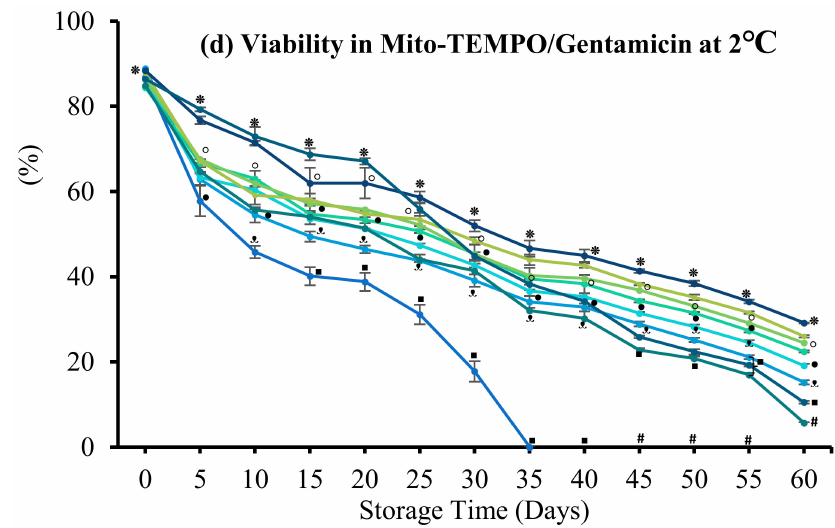
Figure 6. Effect of Mito-TEMPO on spotted halibut ( Verasper variegatus ) sperm stored in Stein’s solution (1:4) + neomycin (N) or gentamicin (G) at 2 ◦ C for 60 days. ( a ) Motility in neomycin (%), ( b ) Figure 4. Effect of gentamicin (G) on the sperm of spotted halibut ( Verasper variegatus ) stored in Stein’s solution for 60 days at 2 °C. ( a ) Motility (%), ( b ) viability Figure 4. Effect of gentamicin (G) on the sperm of spotted halibut ( Verasper variegatus ) stored in Stein’s solution for 60 days at 2 °C. ( a ) Motility (%), ( b ) viability Figure 4. Effect of gentamicin (G) on the sperm of spotted halibut ( Verasper variegatus ) stored in Stein’s solution for 60 days at 2 °C. ( a ) Motility (%), ( b ) viability Figure 4. Effect of gentamicin (G) on the sperm of spotted halibut ( Verasper variegatus ) stored in Stein’s solution for 60 days at 2 °C. ( a ) Motility (%), ( b ) viability Figure 4. Effect of gentamicin (G) on the sperm of spotted halibut ( Verasper variegatus ) stored in Stein’s solution for 60 days at 2 °C. ( a ) Motility (%), ( b ) viability viability in neomycin (%), ( c ) Motility in gentamicin (%), and ( d ) viability in gentamicin (%). Symbols (%), ( c ) average path velocity (VAP; µm/s), ( d ) curvilinear line velocity (VCL; µm/s), ( e ) straight-line velocity (VSL; µm/s), ( f ) linearity (LIN; %), ( g ) straightness (%), ( c ) average path velocity (VAP; µm/s), ( d ) curvilinear line velocity (VCL; µm/s), ( e ) straight-line velocity (VSL; µm/s), ( f ) linearity (LIN; %), ( g ) straightness (%), ( c ) average path velocity (VAP; µm/s), ( d ) curvilinear line velocity (VCL; µm/s), ( e ) straight-line velocity (VSL; µm/s), ( f ) linearity (LIN; %), ( g ) straightness (%), ( c ) average path velocity (VAP; µm/s), ( d ) curvilinear line velocity (VCL; µm/s), ( e ) straight-line velocity (VSL; µm/s), ( f ) linearity (LIN; %), ( g ) straightness (%), ( c ) average path velocity (VAP; µm/s), ( d ) curvilinear line velocity (VCL; µm/s), ( e ) straight-line velocity (VSL; µm/s), ( f ) linearity (LIN; %), ( g ) straightness (STR; %), and ( h ) duration motility (minutes). Symbols ( ⁕ , ⸰ , • , ᵜ , ▪ ) indicate significant differences ( p < 0.05). (STR; %), and ( h ) duration motility (minutes). Symbols ( ⁕ , ⸰ , • , ᵜ , ▪ ) indicate significant differences ( p < 0.05). (STR; %), and ( h ) duration motility (minutes). Symbols ( ⁕ , ⸰ , • , ᵜ , ▪ ) indicate significant differences ( p < 0.05). (STR; %), and ( h ) duration motility (minutes). Symbols ( ⁕ , ⸰ , • , ᵜ , ▪ ) indicate significant differences ( p < 0.05). (STR; %), and ( h ) duration motility (minutes). Symbols ( ⁕ , ⸰ , • , ᵜ , ▪ ) indicate significant differences ( p < 0.05).